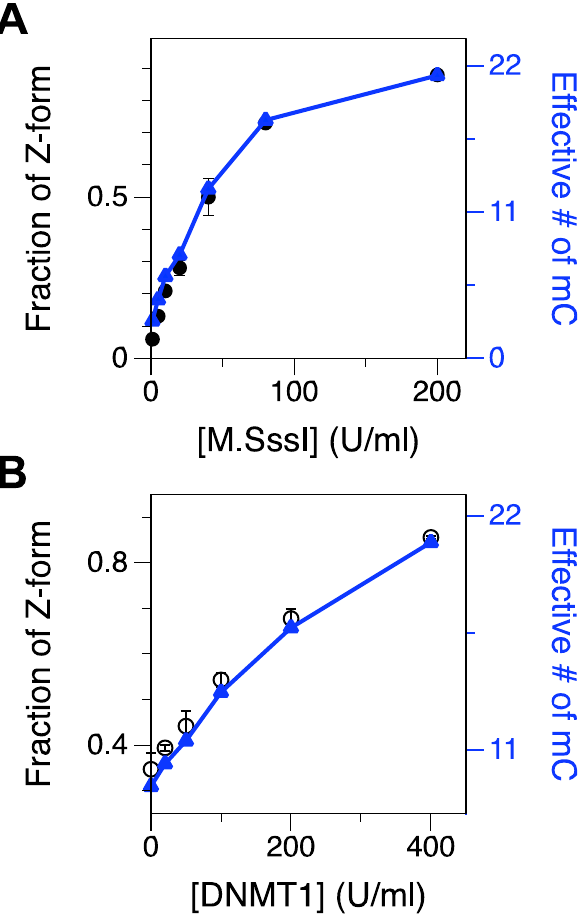
Figure 2. Fractions of Z-form of an initially UM or HM CG core after 2-h incubation with various concentrations of M.SssI (1–200 U/mL) or DNMT1 (20–400 U/mL), respectively. The populations were measured in the presence of 50 mM Mg 2+ . FRET efficiency histograms for cores treated with various concentrations of DMT are shown in Supplementary Materials, Figure S5. ( A ) Fraction of Z-form vs. [M.SssI] (black) overlaid with the effective number of methylated cytosines (blue). ( B ) Fraction of Z-form vs. [DNMT1] (black) overlaid with the effective number of methylated cytosines (blue).